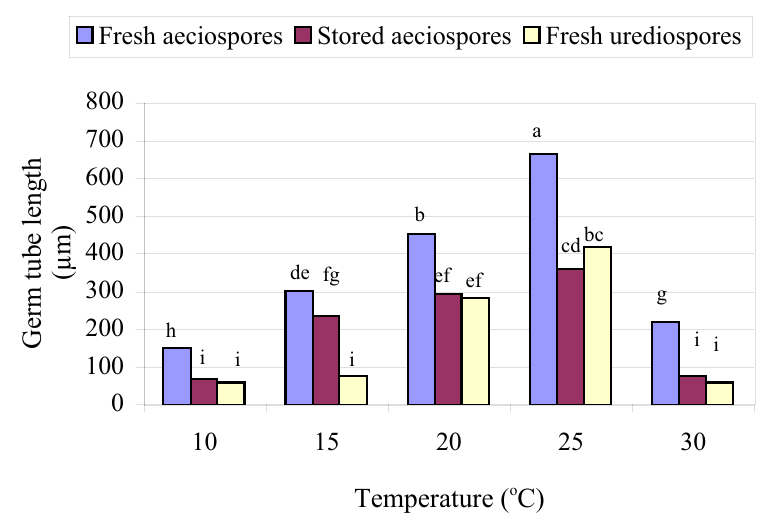
Fig. 2. Effect of temperature on germ tube length of fresh and stored aeciospores and of fresh urediospores of Pileolaria terebinthi. Bars with the same letter(s) are not significantly different ( P =0.01).